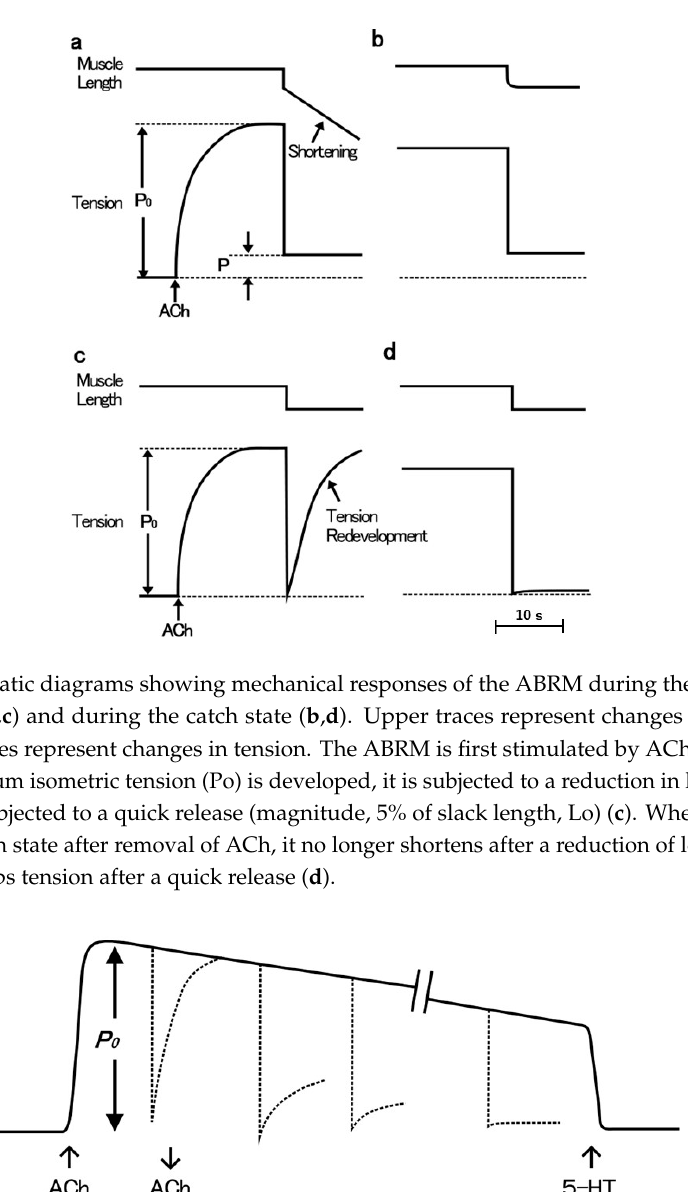
Figure 2. Diagram of tension record illustrating the transition from the active to the catch state. The ABRM is first made to contract actively with ACh, and after the maximum isometric tension (Po) is developed, is subject to quick releases to drop the tension to zero at various times after the application and following removal of ACh. Dotted lines indicate time course of tension redevelopment following quick releases. The catch tension is made to relax with 5-HT.